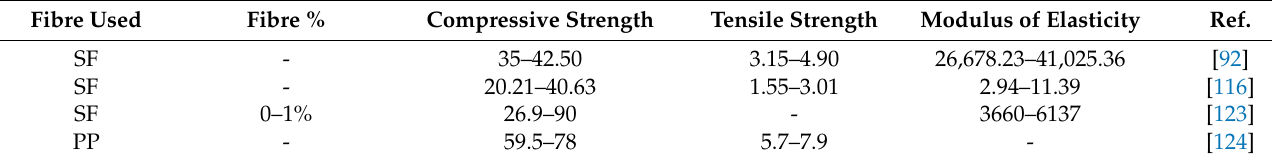
Figure 8. Modulus of Elasticity in MPa [92]. Table 4. Hardened concrete